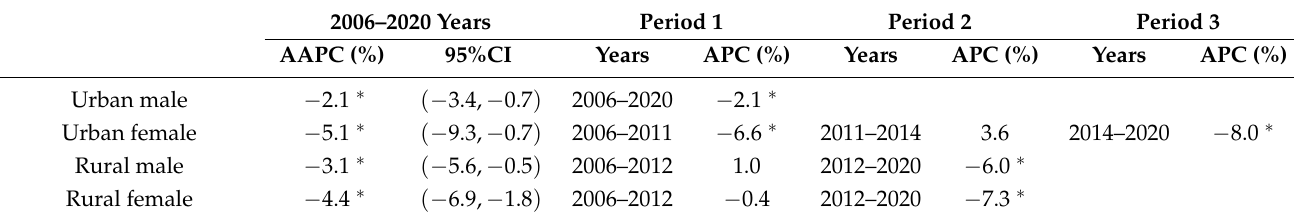
Table 1. AAPC and APC of standardized mortality rate of RHD among urban and rural men and women in